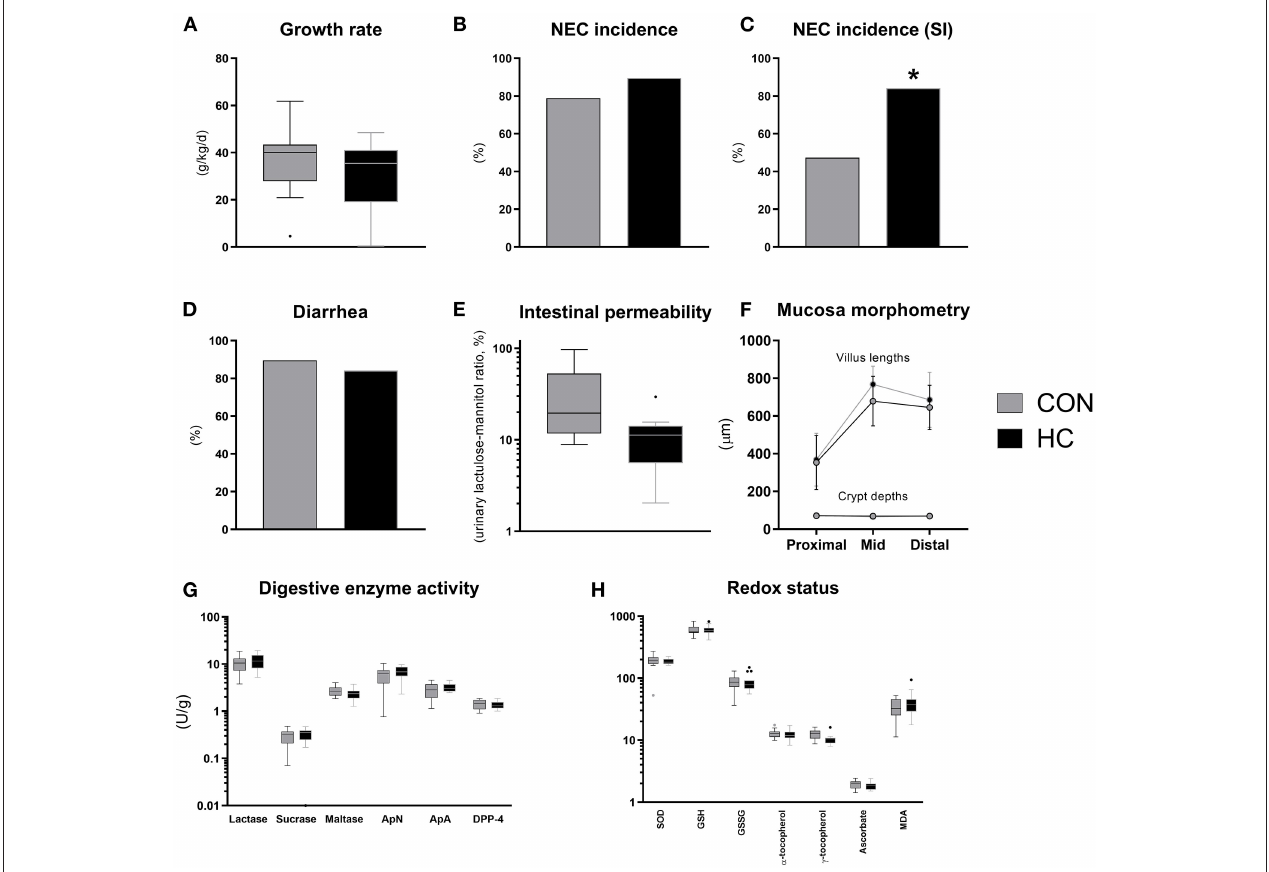
FIGURE 6 | Body growth rate (A) , overall and small intestinal (SI) NEC incidence (B,C) , proportion of pigs with diarrhea (D) , urinary lactulose-mannitol ratio as a measure of intestinal permeability (E) , small intestinal villus and crypt morphology (F) , activity of brush-border disaccharidases (lactase, sucrase, maltase) and aminopeptidases (aminopeptidase N, ApN; aminopeptidase A, ApA; dipeptidyl peptidase-4, DPP-4) (G) , markers of oxidative stress in small intestinal tissue (superoxide dismutase activity, SOD, U/g; reduced (GSH) and oxidized glutathione, GSSG, both nmol/g; α - and γ -tocopherol, both nmol/g; ascorbate, µ mol/g; malondialdehyde, MDA, nmol/g) (H) . Dichotomous data is reported as frequencies. Longitudinal data is presented as means with standard deviations, while remaining continuous data is presented as box plots (box edges denote interquartile ranges and horizontal line denotes the median value) with Tukey whiskers (outliers shown as dots). *Denotes a probability value below 0.05. HC, hydrocortisone; CON,